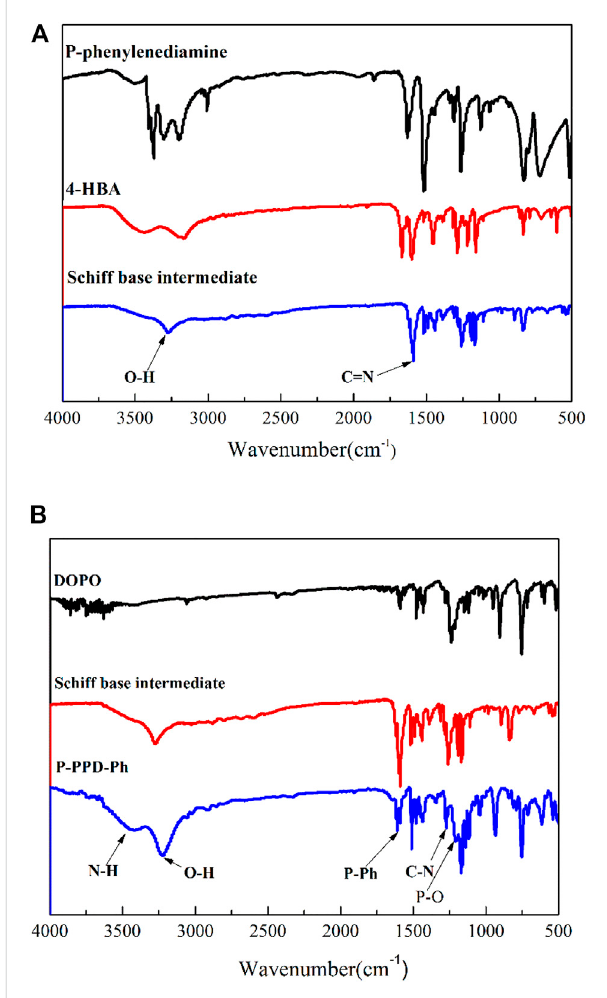
FTIR spectrum of (A) imine compounds and (B)